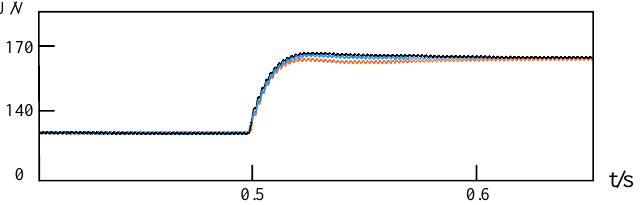
Figure 16. Voltage balancing control strategy tracks the situation as the reference voltage changes.